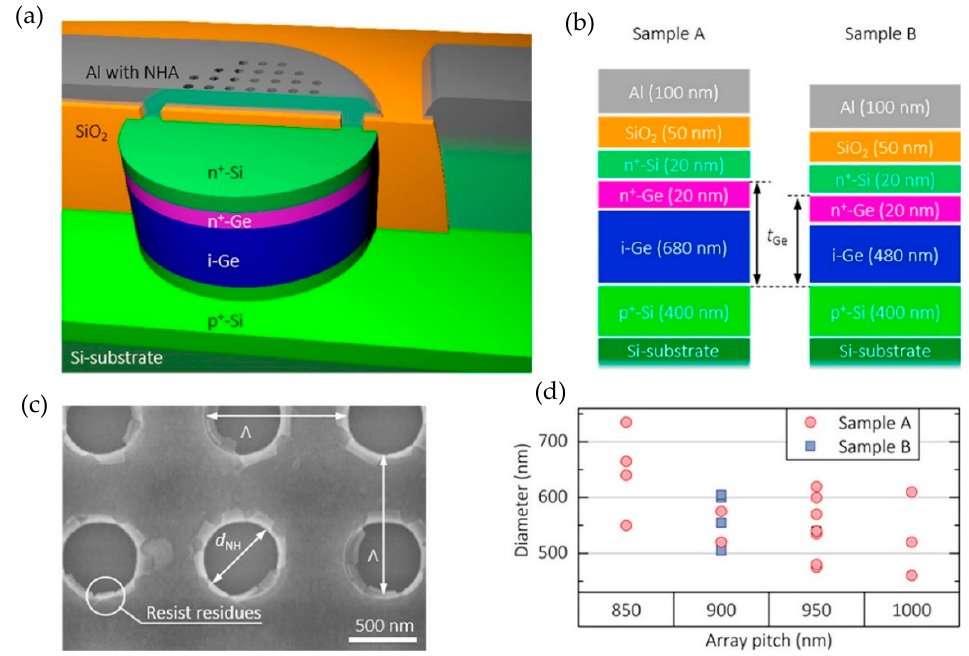
Figure 8. ( a ) Schematic illustration of the device presented in Augel et al. [73], showing the cross section of the germanium PD and integrated aluminum nanohole array in the metal contact area. ( b ) Schematic showing the layers of the germanium PD where the germanium layer thickness is 780 nm and 500 nm for sample A and B respectively. ( c ) SEM image of the aluminum nanohole array integrated with the germanium PD. ( d ) The physical parameters (hole diameter and the pitch) of various nanohole arrays fabricated in the metal contact area of the germanium PD. Reprinted with permission from [73]. Copyright © American Chemical Society (ACS) (2018).